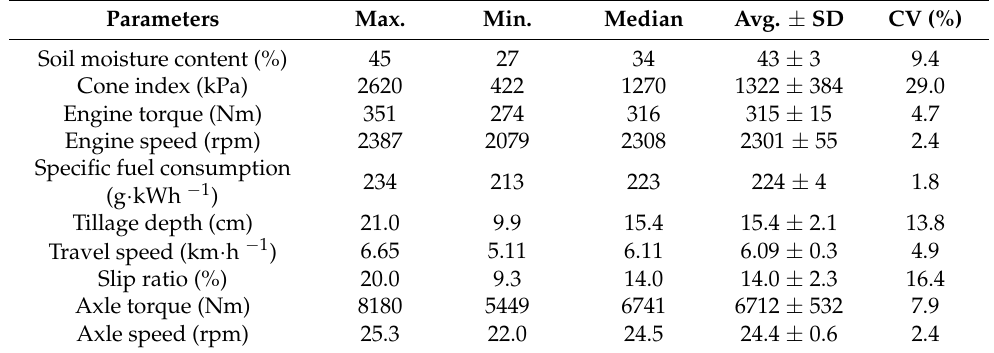
Table 2. Statistical analysis results of soil physical properties and major tractor